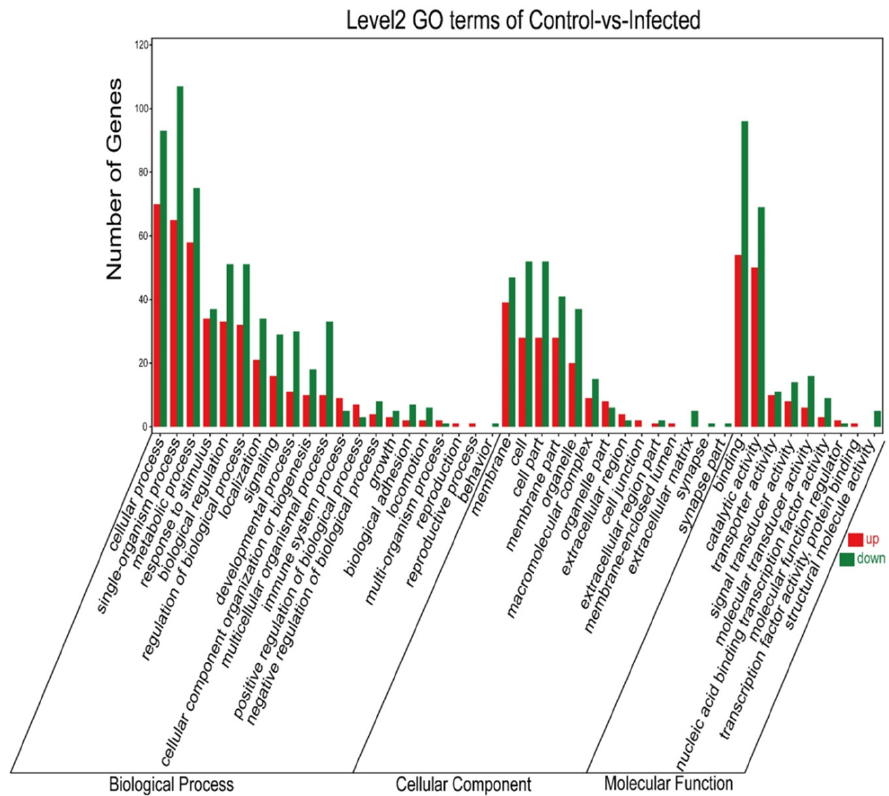
Fishes 2022 , 7 , x FOR PEER REVIEW Figure 5. GO enrichment classification histogram. The abscissa is the secondary GOterm; the ordinate is the number of differential genes in the term; red means upregulated; green means downregulated.